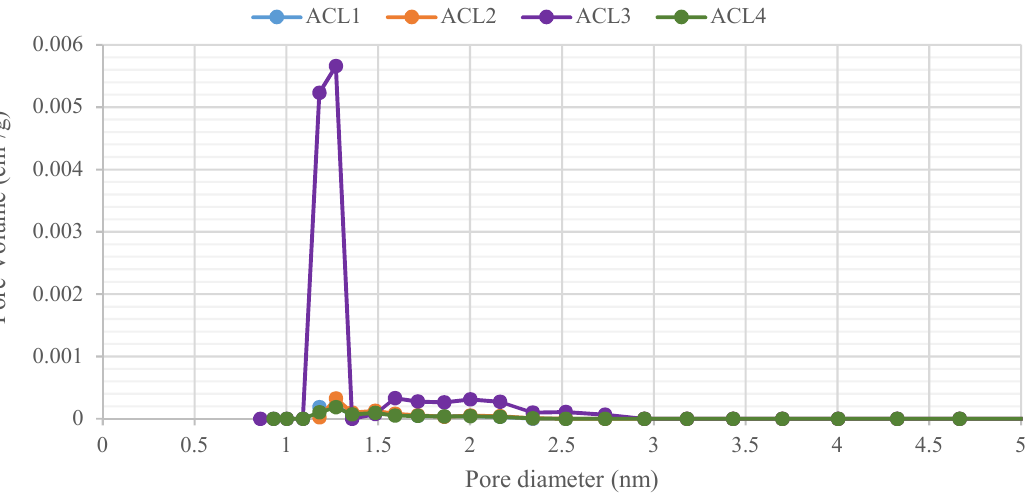
Figure 4. Pore size distributions of different activated carbon layers. Each color represents a different insert’s activated carbon layer.